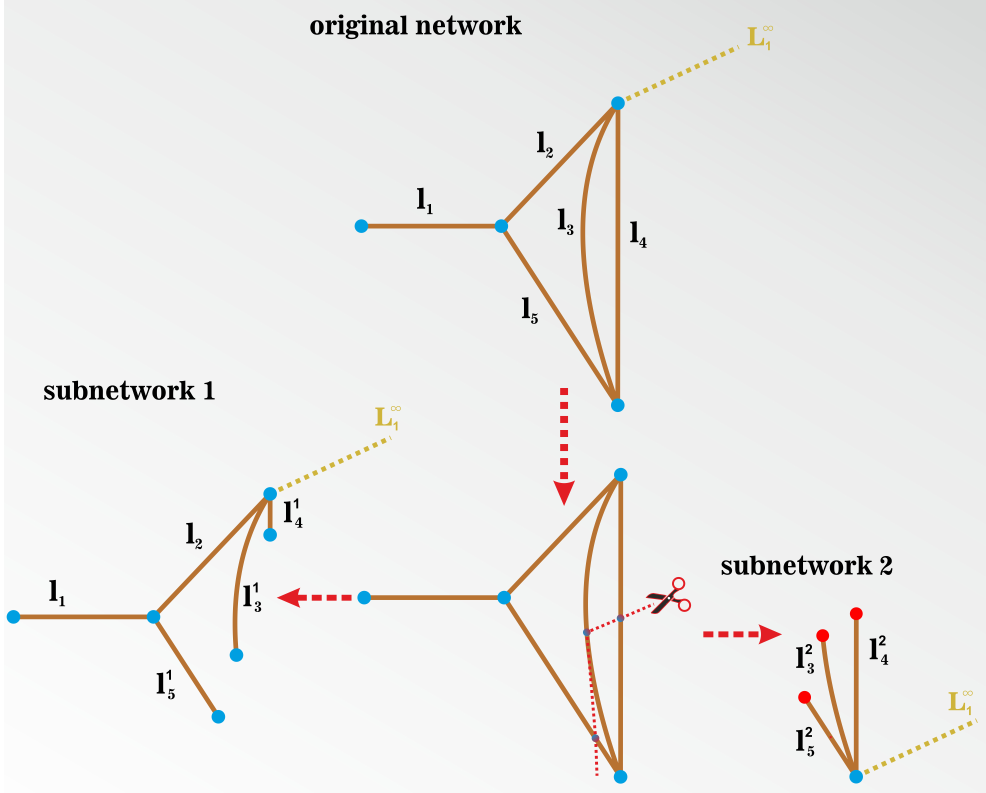
Figure 1. The scheme of the original network Γ o ( 4,5,0 ) which was split at edges into two subnet- works Γ 1 ( 6,5,0 ) and Γ 2 ( 4,3,3 ) . In this case, the original network Γ o ( 4,5,0 ) and the subnetwork 1 Γ 1 ( 6,5,0 ) possess vertices with the Neumann boundary conditions which are marked by blue dots. The subnetwork 2 Γ 2 ( 4,3,3 ) possesses the mixed boundary conditions: three vertices with the Dirichlet boundary conditions (red dots) and one vertex with the Neumann boundary condition (blue dot). L ∞ marks the semi-infinite lead attached to the 1